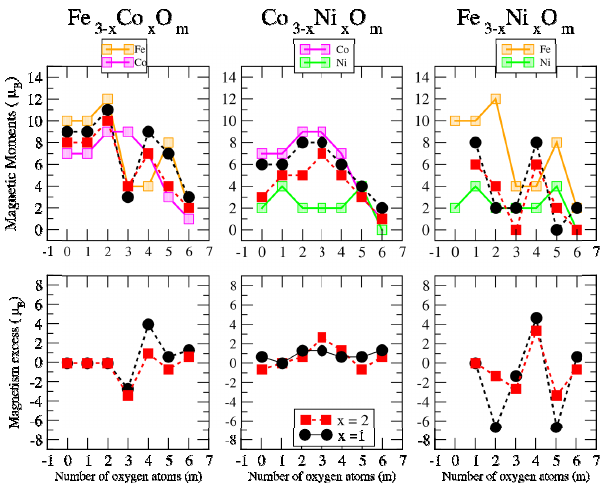
Figure 13. ( upper pannels ) Total magnetic moments of A 3 − x B x O m clusters (A, B = Fe, Co, Ni; 0 ≤ x ≤ 3; m = 1–7). Brown, pink and green curves correspond, respectively, to Fe n O m , Co n O m and Ni n O m oxides. Black and red curves correspond to nanoalloys with x = 1, 2, respectively. ( lower panels ) Magnetism excess of A 3 − x B x O m clusters (A, B = Fe, Co, Ni; 1 ≤ x ≤ 2; m =